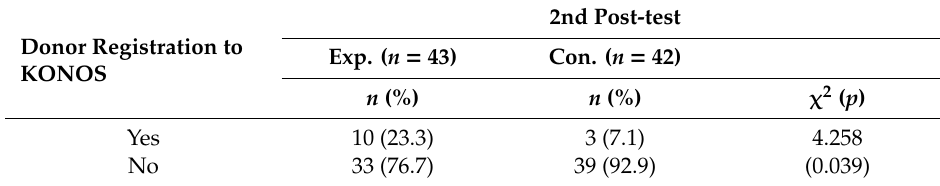
Table 6. Group di ff erences in donor registration for